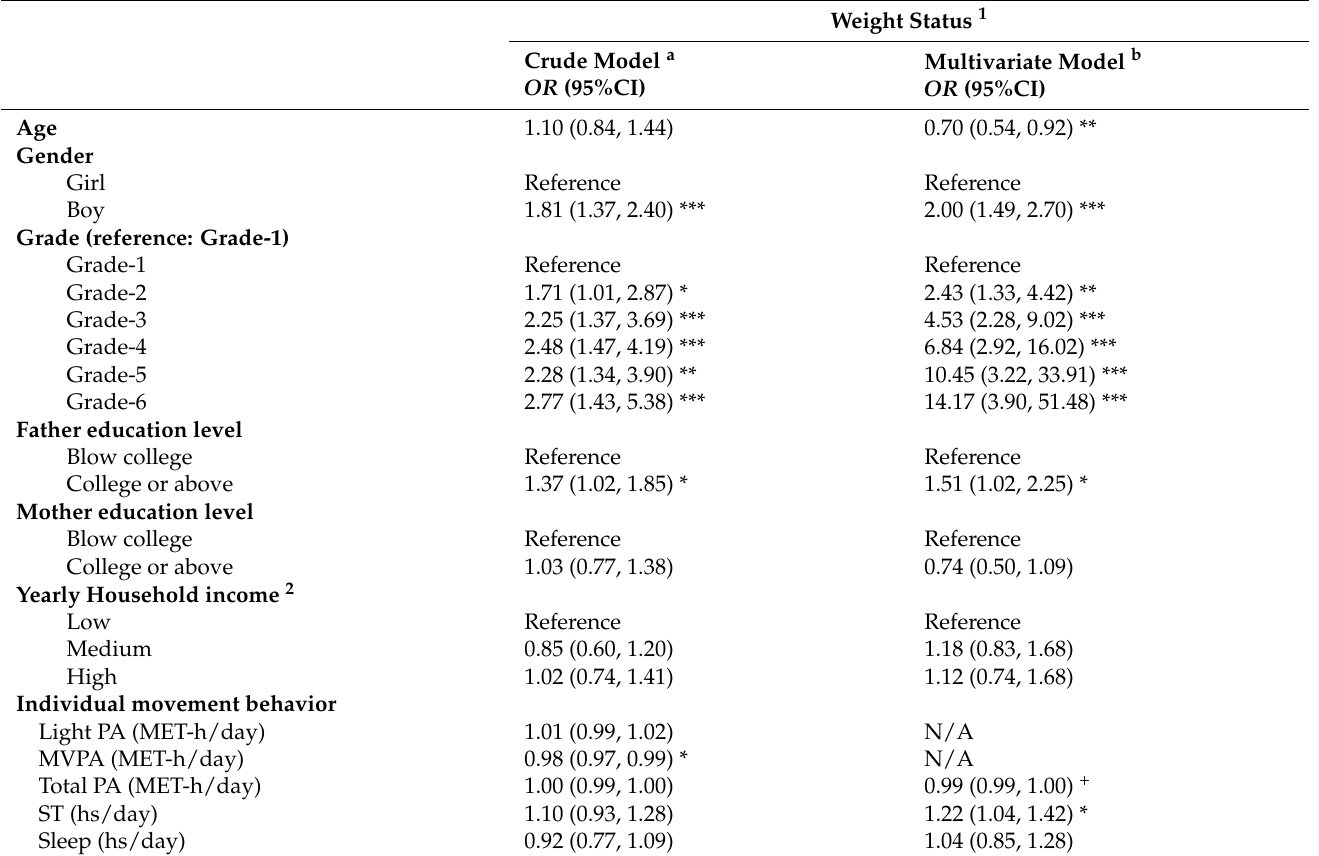
Table 2. Associations of individual movement behavior with weight status among the study sample ( n =